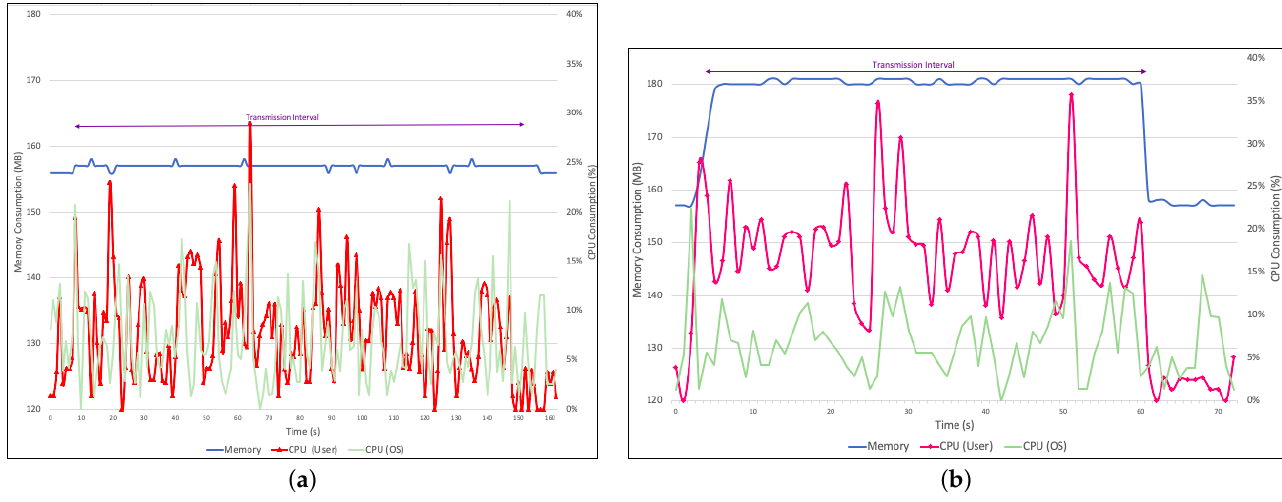
Figure 6. Sensing node sending 1500 AIS entries. ( a ) Sending data via SSH. ( b ) Sending data via blockchain transactions.